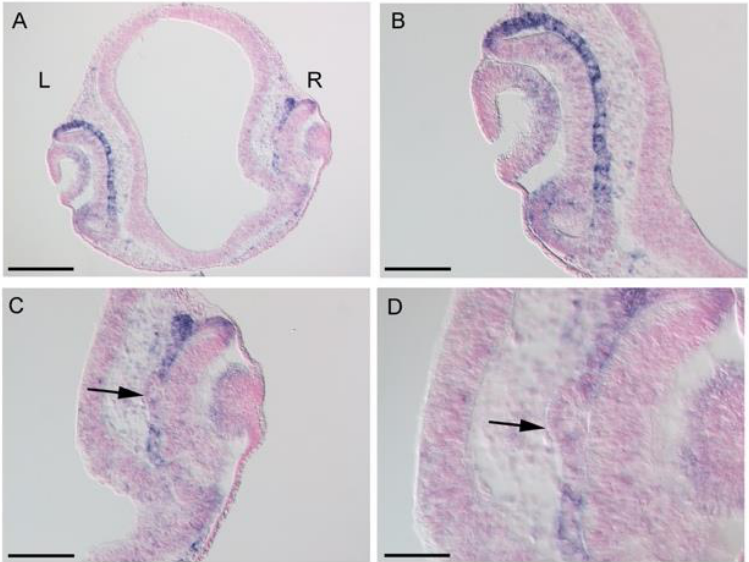
Figure 4. BHLHE40 expression after LHX1 overexpression. ( A ) In situ hybridization (ISH) on the frontal section of the chicken embryonic head after 1 day post electroporation (embryo #5). Enlarged view of the left (L) control optic cup (OC) is shown in ( B ), and that of the right (R) Lhx1 -overexpressed one is shown in ( C , D ). BHLHE40 expression is downregulated in a portion of the outer layer of the OC (arrows in C , D ). Cell nuclei were stained with nuclear fast red. Scale bars: 200 μm ( A ), 100 μm ( B , C ), 50 μm ( D ). Similar data from other embryos are shown in Supplementary Figure S5.